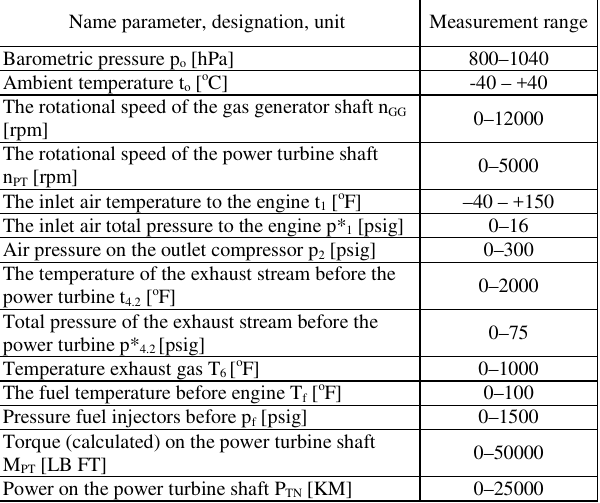
Fig. 5. Block diagram of LM 2500 gas turbine engine Table 2. Operating parameters LM 2500 engine Fig. 6. Arrangement of air intake and LM 2500 engine exhaust outlet mounted on an Oliver Hazard Perry class missile